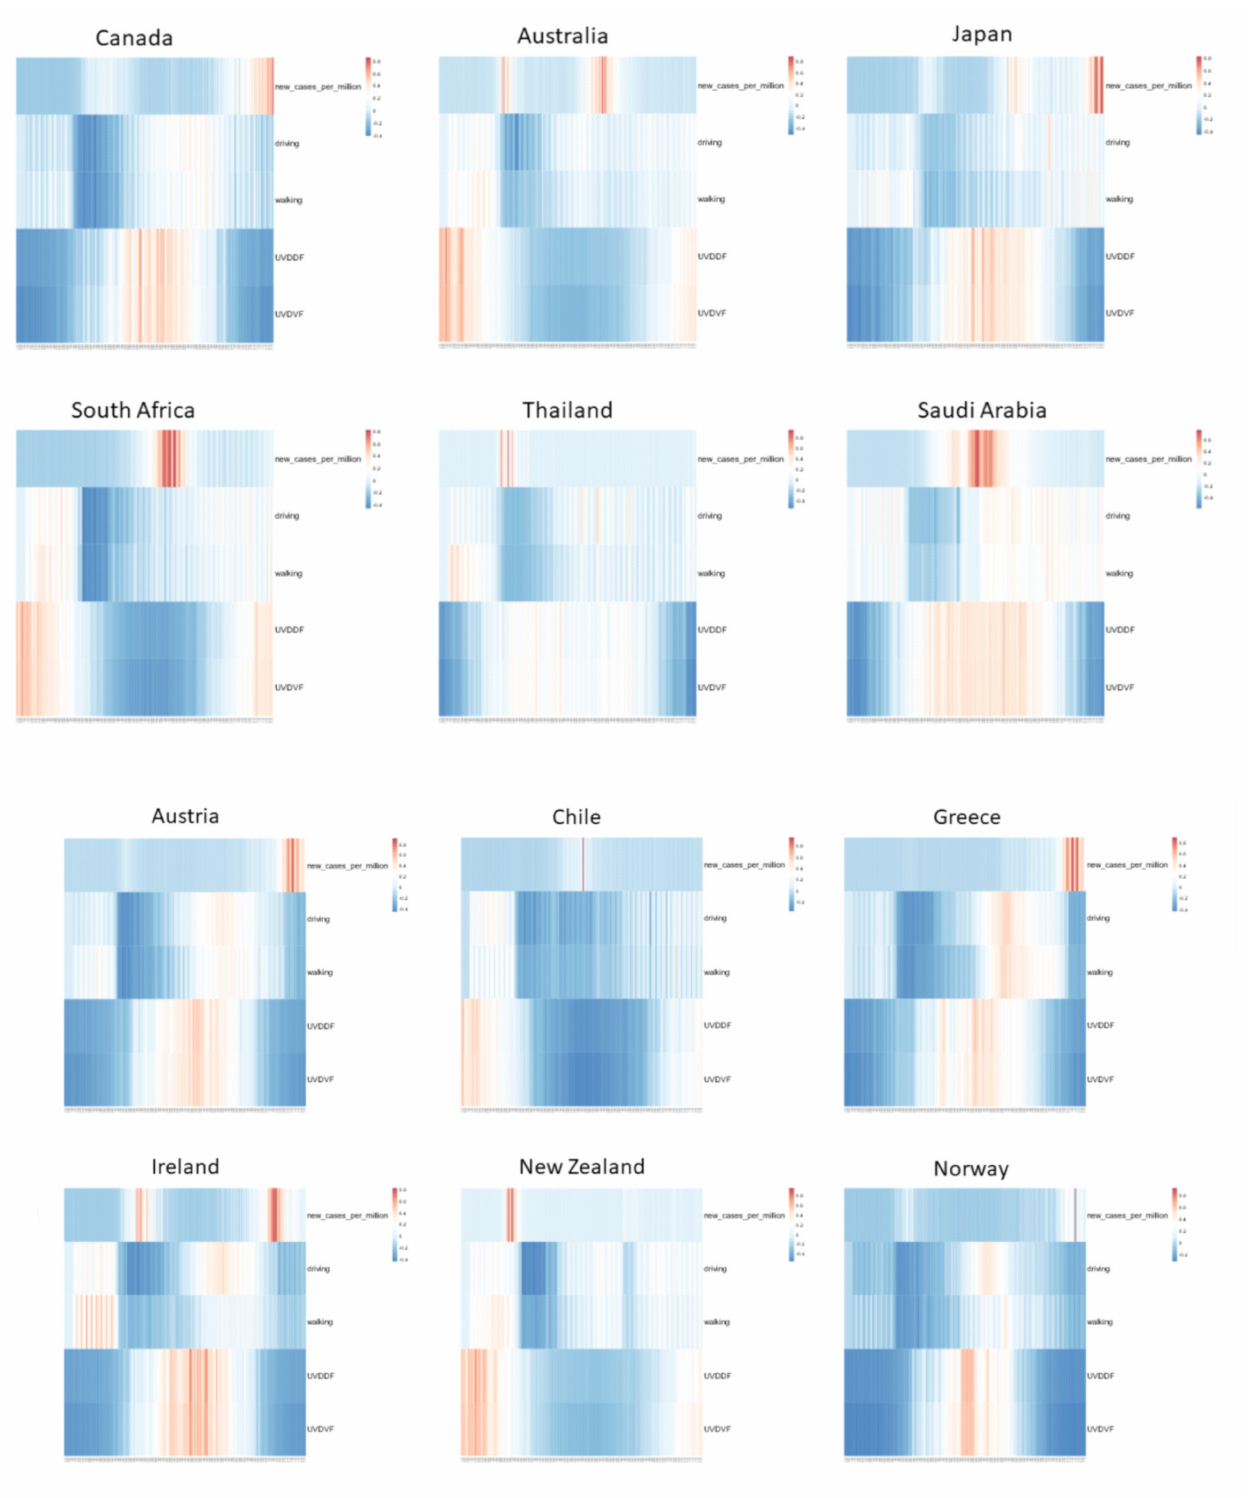
Figure 3. Display of normalized values of model parameters for target countries. The more familiar quotidian-dependent monitoring of model parameters is shown with day of the year ( x -axis, 1 January to 30 November) and new daily cases, driving, walking, UVDDF and vitamin D index UV dose (UVDVF) are shown as panels ( y -axis). All values are normalized, color-coded (scale shown, upper right for each case/country), ranging from blue color for negative association to red color for positive association (see